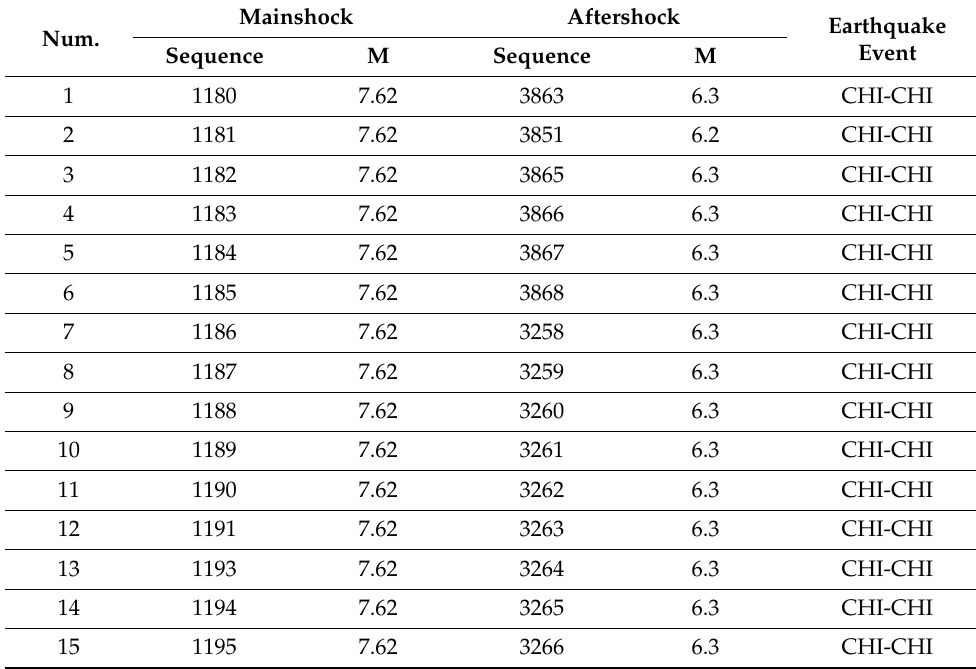
Table 1. Mainshock–aftershock sequences.